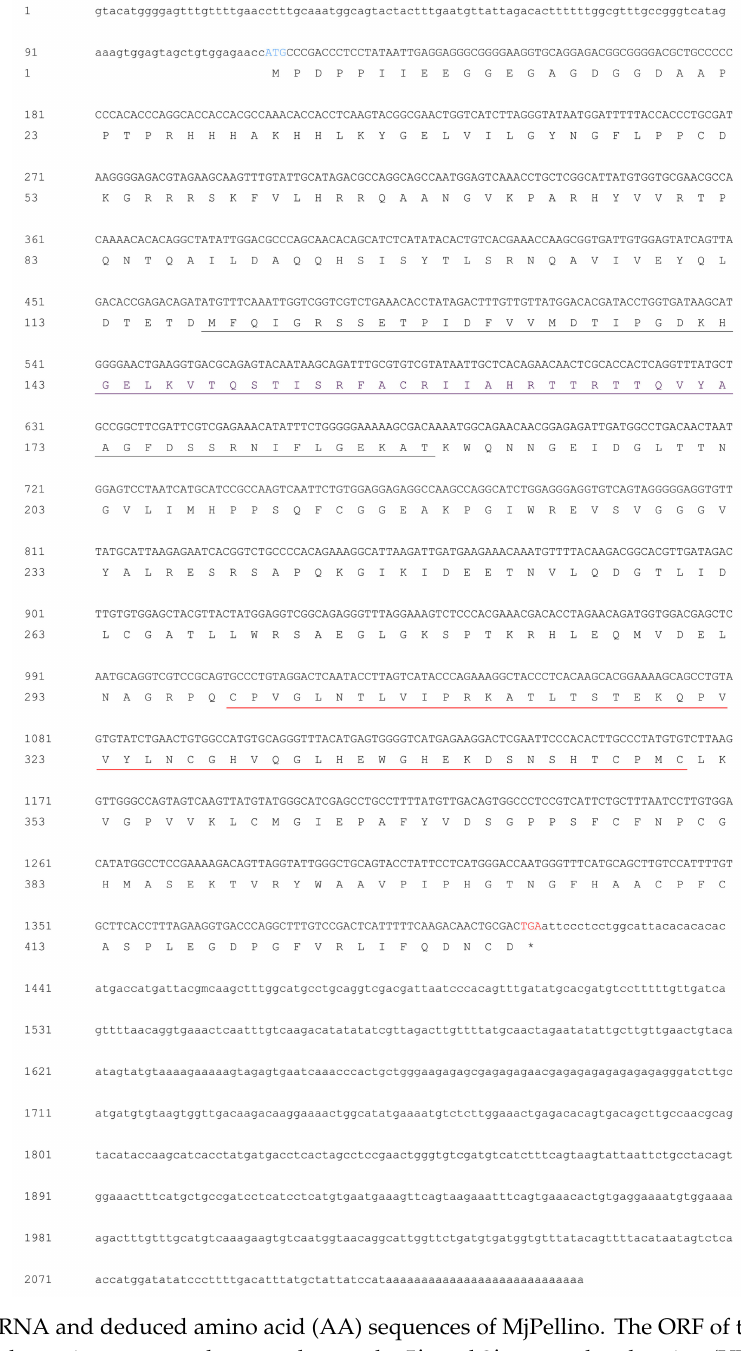
Figure 1. mRNA and deduced amino acid (AA) sequences of MjPellino. The ORF of the nucleotide sequence is shown in uppercase letters, whereas the 5 (cid:48) - and 3 (cid:48) -untranslated region (UTR) sequences are shown in lowercase letters. The initiation codon ATG is highlighted in blue, and the termination codon TGA is highlighted in red. The forkhead-associated (FHA) domain in the N-terminal 118–188 region is underlined in gray, and the RING E3 ubiquitin ligase domain is marked with a red